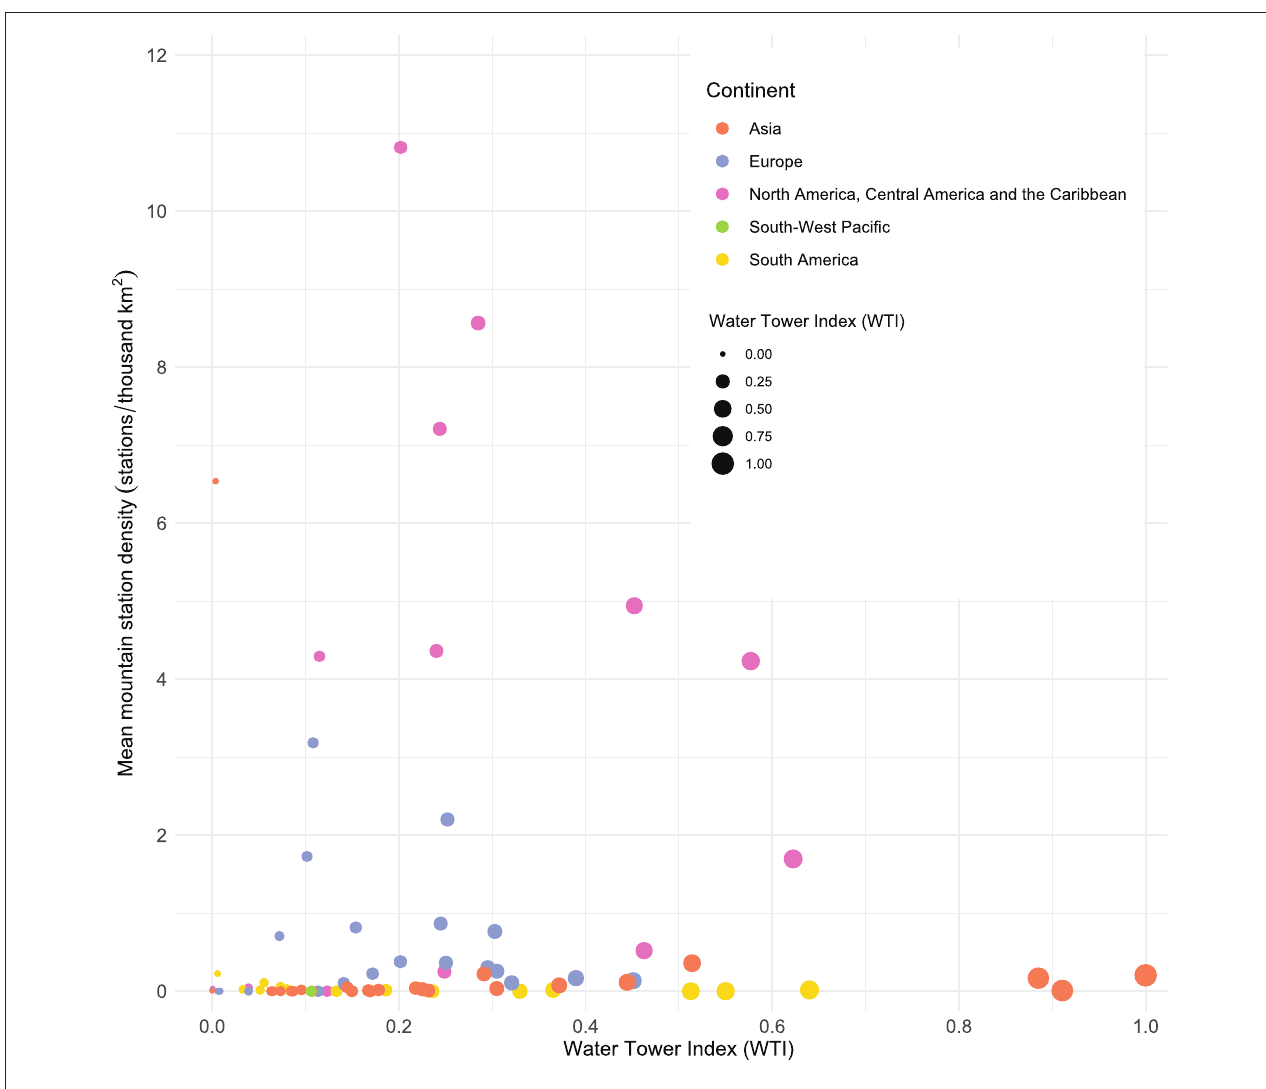
FIGURE 12 | Mean mountain GHCNd station density for each Water Tower Unit (WTU) against that WTU’s Water Tower Index